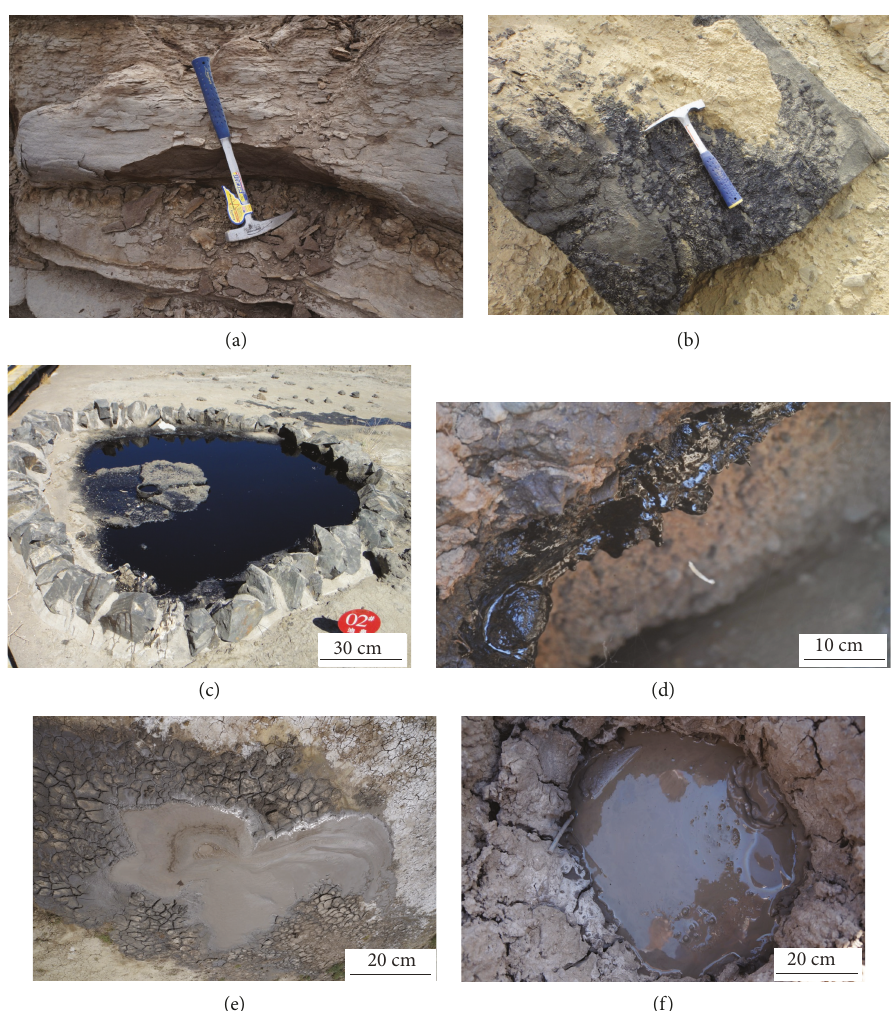
Figure 3: Photographs showing oil and gas seeps in the Junggar Basin. (a) The Shaqiuhe oil sand; (b) the Wuerhe bitumen; (c) the Heiyoushan crude-oil seep; (d) the Qigu crude-oil seep; (e) the Wusu mud volcano; (f) the Dushanzi mud